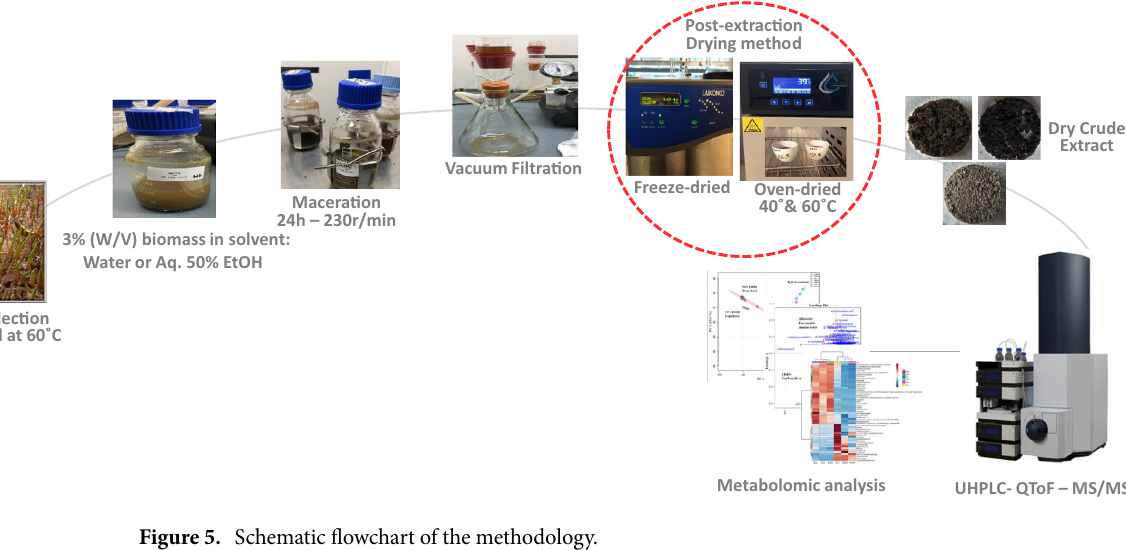
Figure 5. Schematic flowchart of the